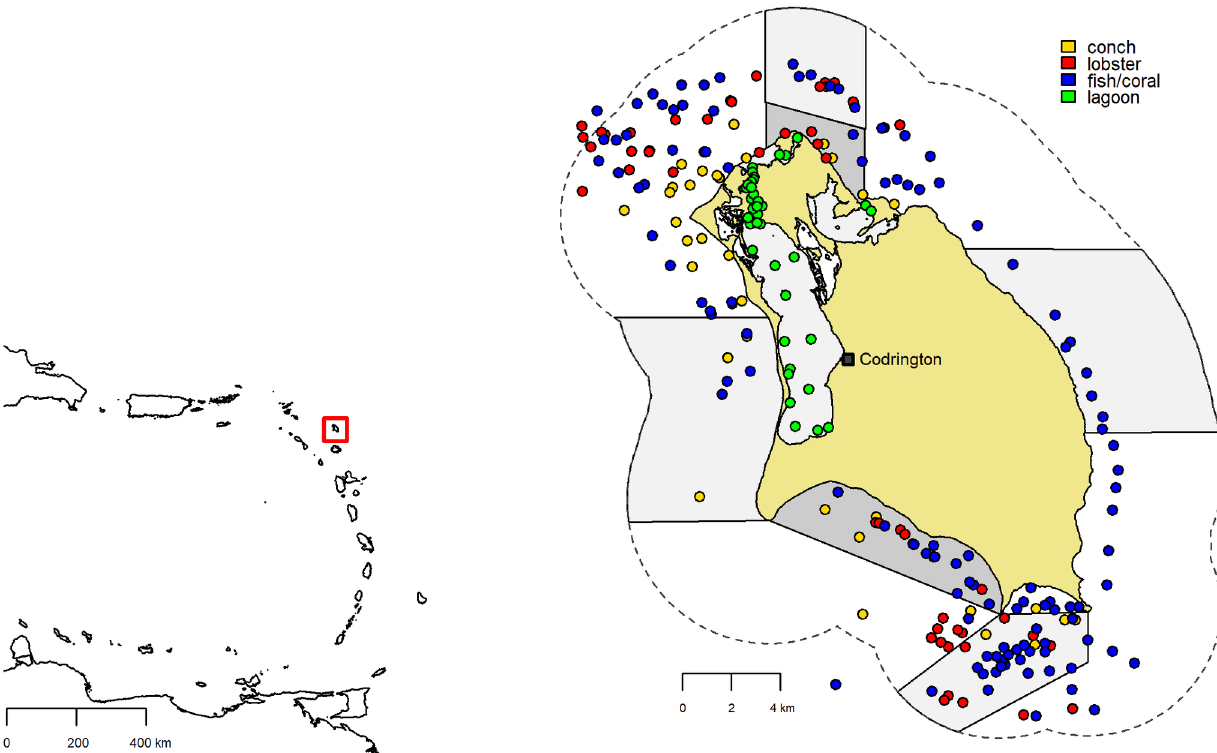
Fig 1. Map of Barbuda. Map of survey sites and types of surveys conducted,with newly-implemented no-take zones marked in light gray and zones where net fishing is prohibitedmarked in darker gray. The 3 nm territorialwaters are indicatedwith a dashedline. CodringtonVillageis marked along the eastern edge of Codrington Lagoon.The inset map shows the Eastern Caribbean, with Barbudamarked with a red box.